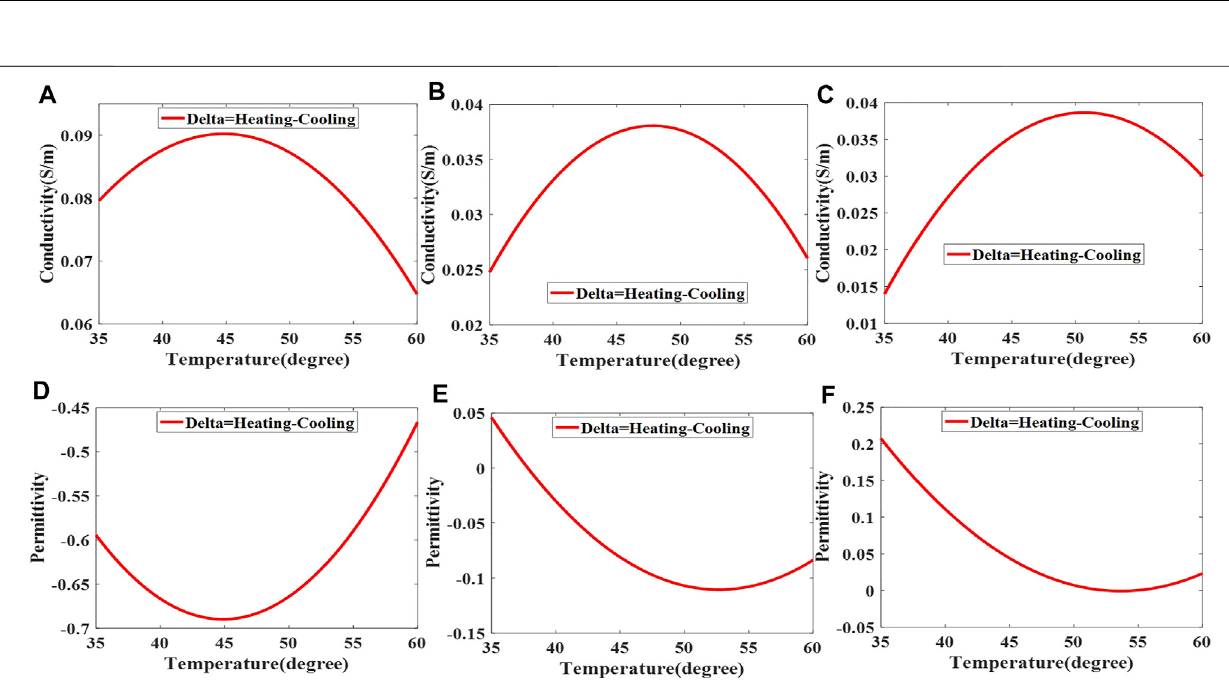
( Figure 5 ) and TAS ( Figure 6 ) of the porcine liver tissues increased, and the relationships were nonlinearly correlated.